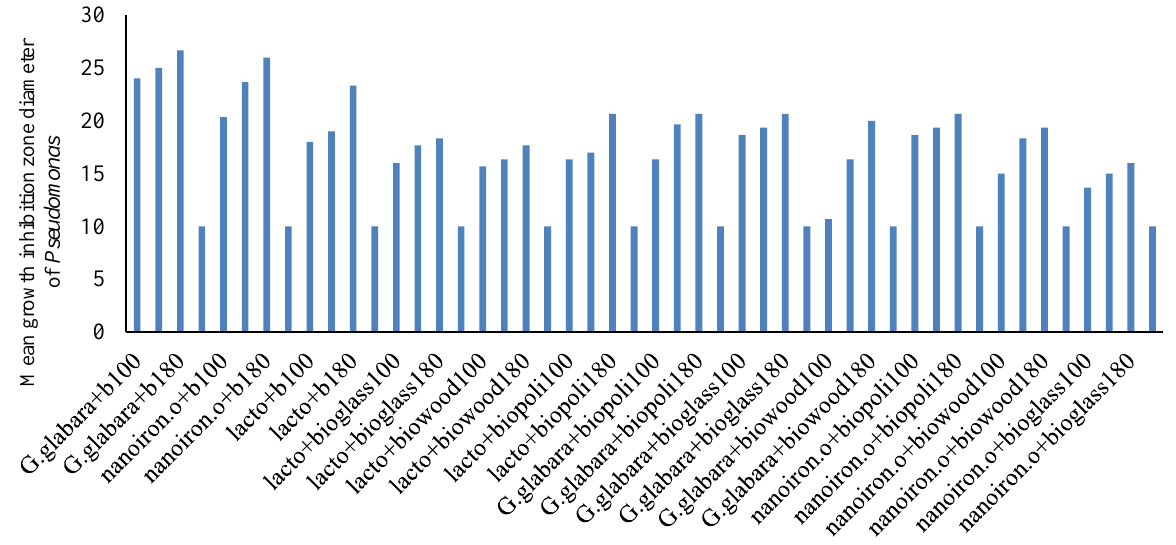
Fig. 8. Diagram of changes in mean growth inhibition zone diameter of P. aeruginosa biofilm against antimicrobial agents